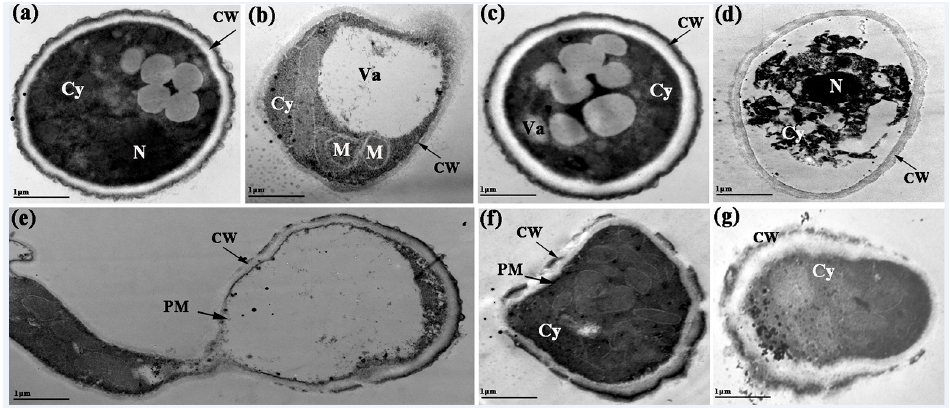
Figure 7. Ultrastructural changes of P. expansum observed by TEM. P. expansum conidia treated with distilled water ( a ), or BanTLP at 60 μ M ( b – g ) for 12 h. The scale bar represents 1 μ m. Each treatment was repeated three times, and at least two blocks were detected for each replicate. Va, vacuole; CW, cell wall; PM, plasma membrane; Cy, cytoplasm; N, nucleus; M, mitochondria. (Magnification ×30,000).